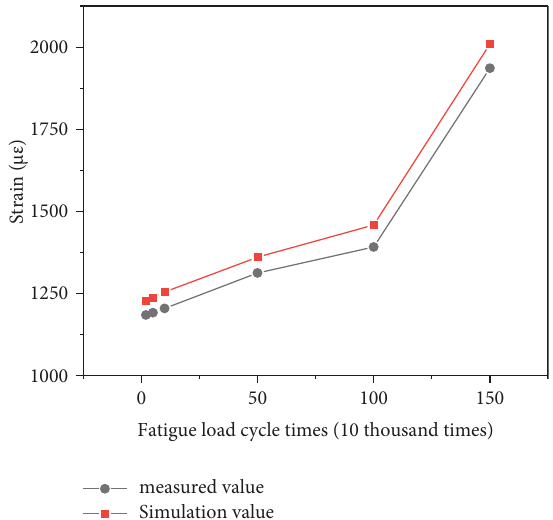
Figure 13: Te relationship between the steel strain and the number of fatigue load